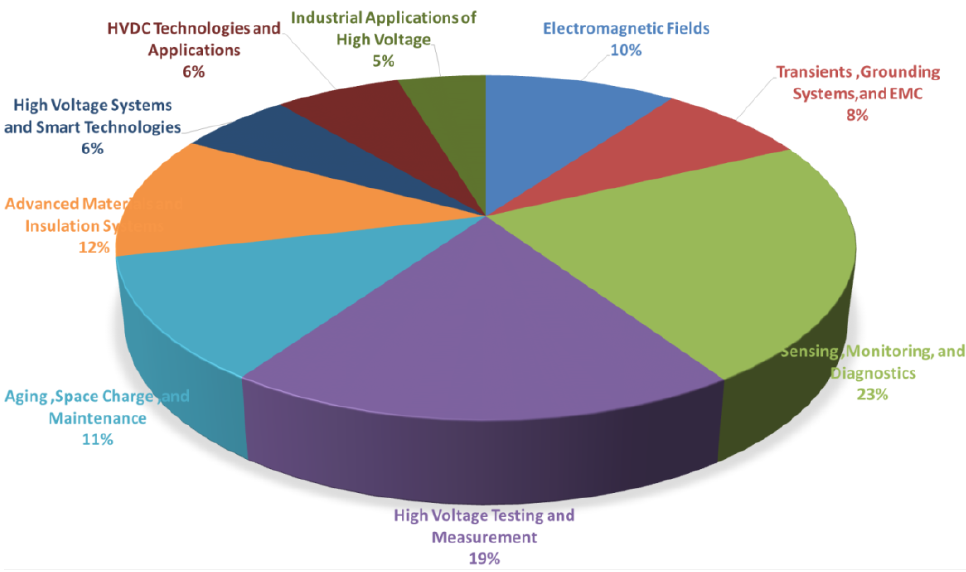
Figure 1. Proportion of papers by